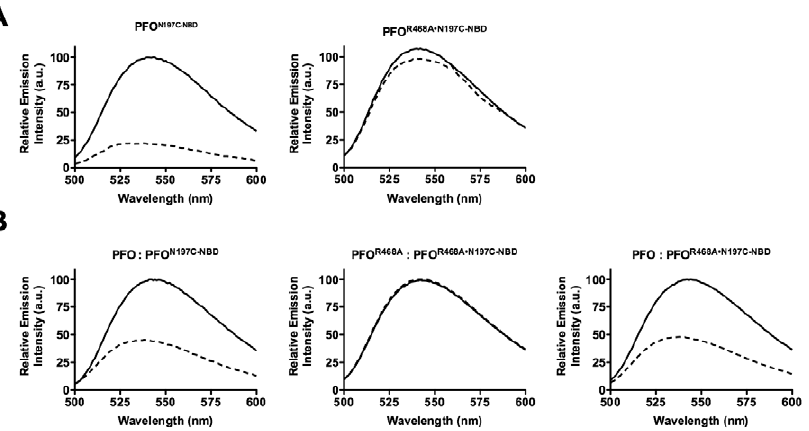
Figure 5. Disruption of the D2/D3 interface in PFO and PFO R468A . (A) A cysteine was substituted for TMH1 residue Asn-197, which is located within the D2/D3 interface. Each derivative was labeled with NBD and incubated in the presence (dashed line) and absence (solid line) of human erythrocyte ghost membranes. If TMH1 breaks its contact with D2 then Asn-197 moves from a buried, nonpolar location at the interface with D2 to the lumen of the pore. An NBD positioned at this location will therefore undergo a nonpolar to polar transition, which results in the quenching of the fluorescence emission. (B) Unlabeled native PFO or PFO R468A were mixed at a 4:1 molar ratio with PFO N197C-NBD and PFO R468A N N197C-NBD derivatives. The fluorescence emission intensity of NBD was measured from 500 to 600 nm. These data are representative of 3